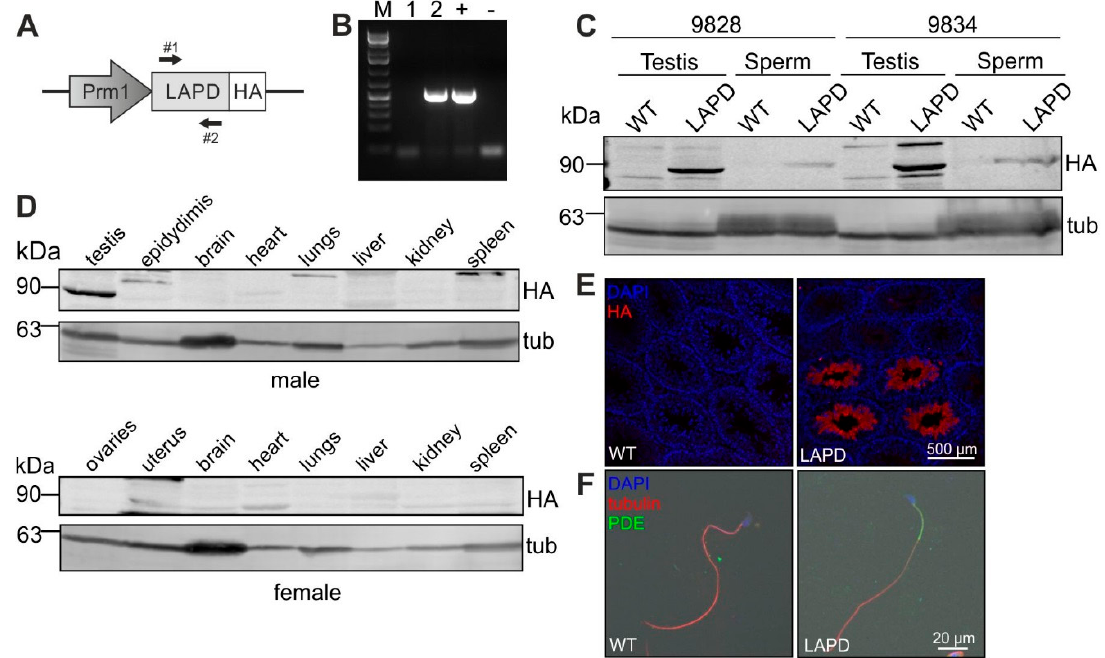
Figure 2. Design and characterization of Prm1-LAPD mice. ( A ) Scheme of the Prm1-LAPD targeting vector. Expression of hemagglutinin (HA)-tagged LAPD is driven by the Protamine 1 promoter (Prm1); arrows indicate the position of genotyping primers. ( B ) Genotyping by PCR. In Prm1-LAPD mice, a 514 bp fragment is amplified. (1) Wild-type mouse, (2) Prm1-LAPD mouse; the targeting vector served as a positive control ( + ) and H 2 O as negative control ( − ). ( C ) Western blot analysis of LAPD-HA expression in testis and sperm of wild-type (WT) and Prm1-LAPD mice (LAPD) from two different founder lines. Immunoblots were stained with HA and alpha-tubulin antibodies. ( D ) Western blot analysis of LAPD-HA expression in various tissues from male and female Prm1-LAPD mice. Immunoblots were stained with HA and alpha-tubulin antibodies. ( E ) Cryo-sections from wild-type (WT) and Prm1-LAPD (LAPD) testes labeled with a HA antibody (red) and DAPI (blue). ( F ) Wild-type (WT) and Prm1-LAPD (LAPD) sperm labeled with PDE2A (green) and alpha-tubulin antibodies (red), and DAPI (blue). Scale bars are indicated.